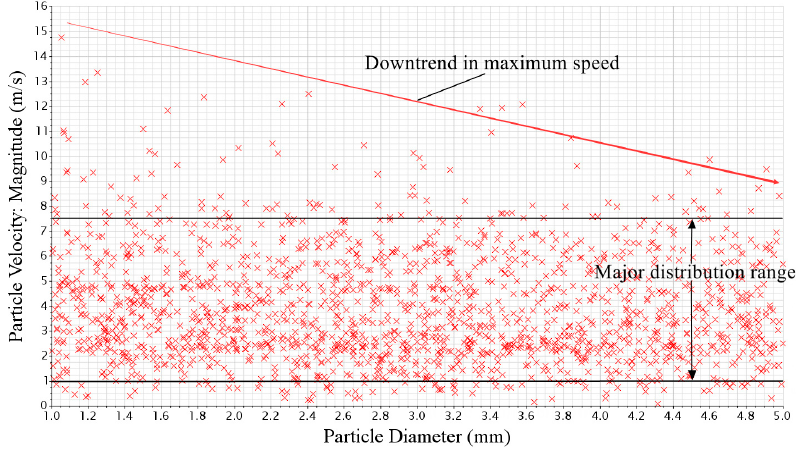
Figure 7. Scatter plot of particle velocity and diameter.